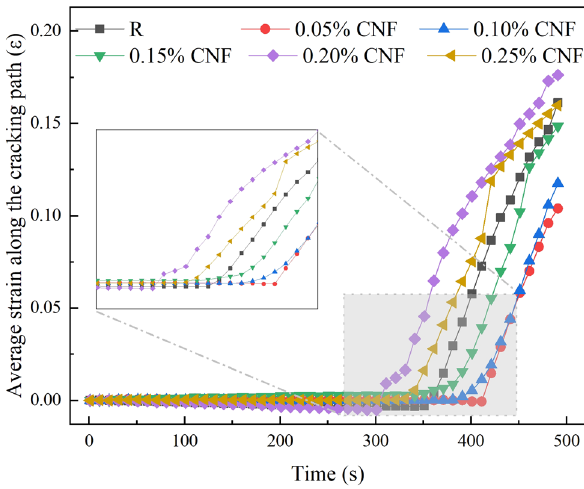
Figure 8: Average strain of specimens with various matrix rheology along the cracking path.